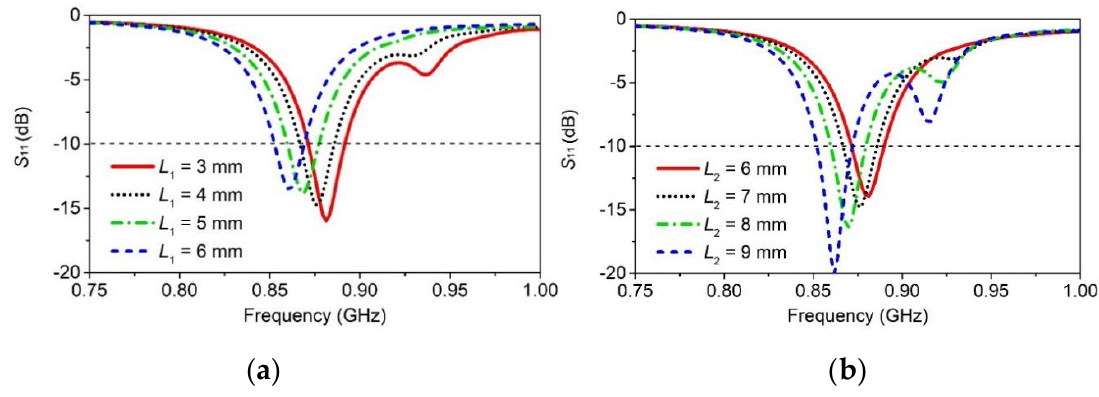
Figure 8. Simulated S 11 response: ( a ) for varying L 1 , ( b ) for varying L 2 .